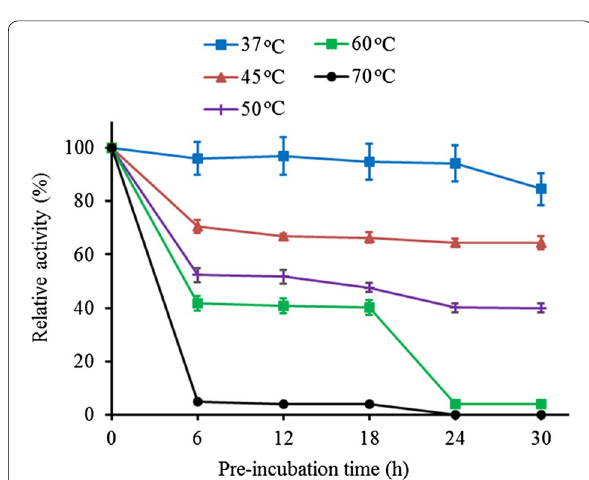
Fig. 8 Effect of temperature on the stability of the AMG activity. The enzyme was pre-incubated for 6, 12, 18, 24, and 30 h before the assay was carried out at 45 °C for 1 h (pH 5.0). All error bars are represented as the standard errors of the means (SEM)